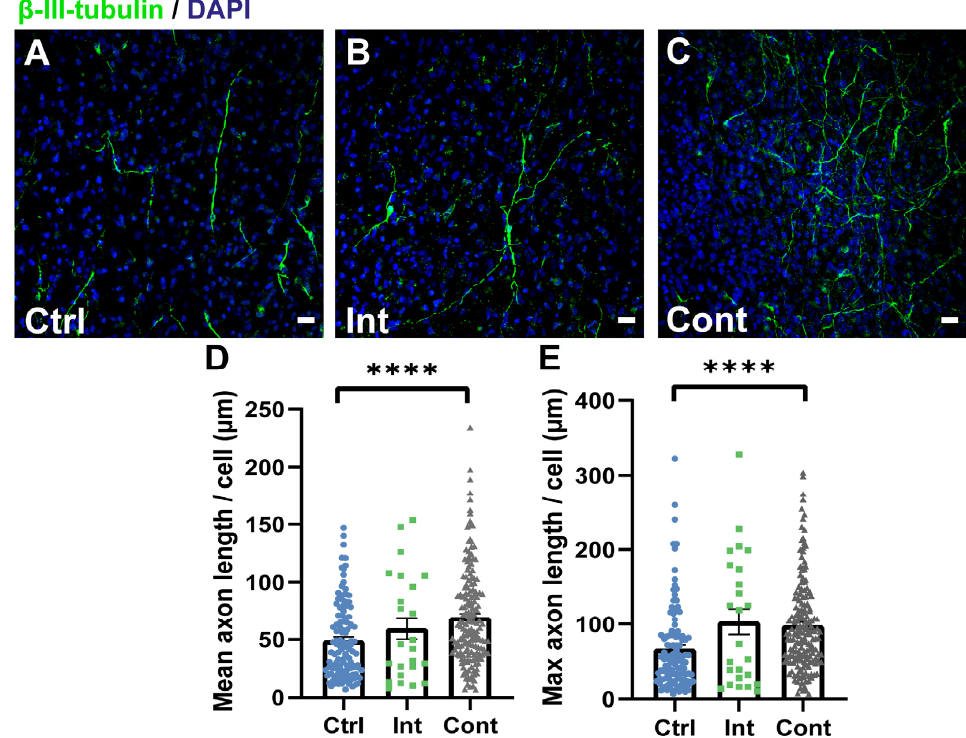
Figure 5. ( A – C ): Representative images of immunocytochemistry staining for β -III-tubulin (green) and DAPI (blue) of the control ( A ), intermittent stimulation ( B ), and continuous stimulation ( C ) groups. Visual inspection of the images shows that continuous stimulation neurons had extended more than the other groups. Scale bars: 20 µm. ( D , E ): Quantification results of the mean axon length per neuron and the maximum axon length per neuron in µm, respectively, for the control (Ctrl), intermittent stimulation (Int), and continuous stimulation (Cont) groups (number of neurons quantified: 115 Ctrl; 25 Int; 175 Cont). ( D ) Mean axon length per neuron in µm (Ctrl: 49.08 ± 3.06 µm; Int: 59.69 ± 9.4 µm; Cont: 69.61 ± 3.17 µm). ( E ) Maximum axon length per neuron in µm (Ctrl: 66.86 ± 5.31 µm; Int: 103.4 ± 17.4 µm; Cont: 98.12 ± 4.62 µm). Data are expressed as mean ± SEM. **** p <